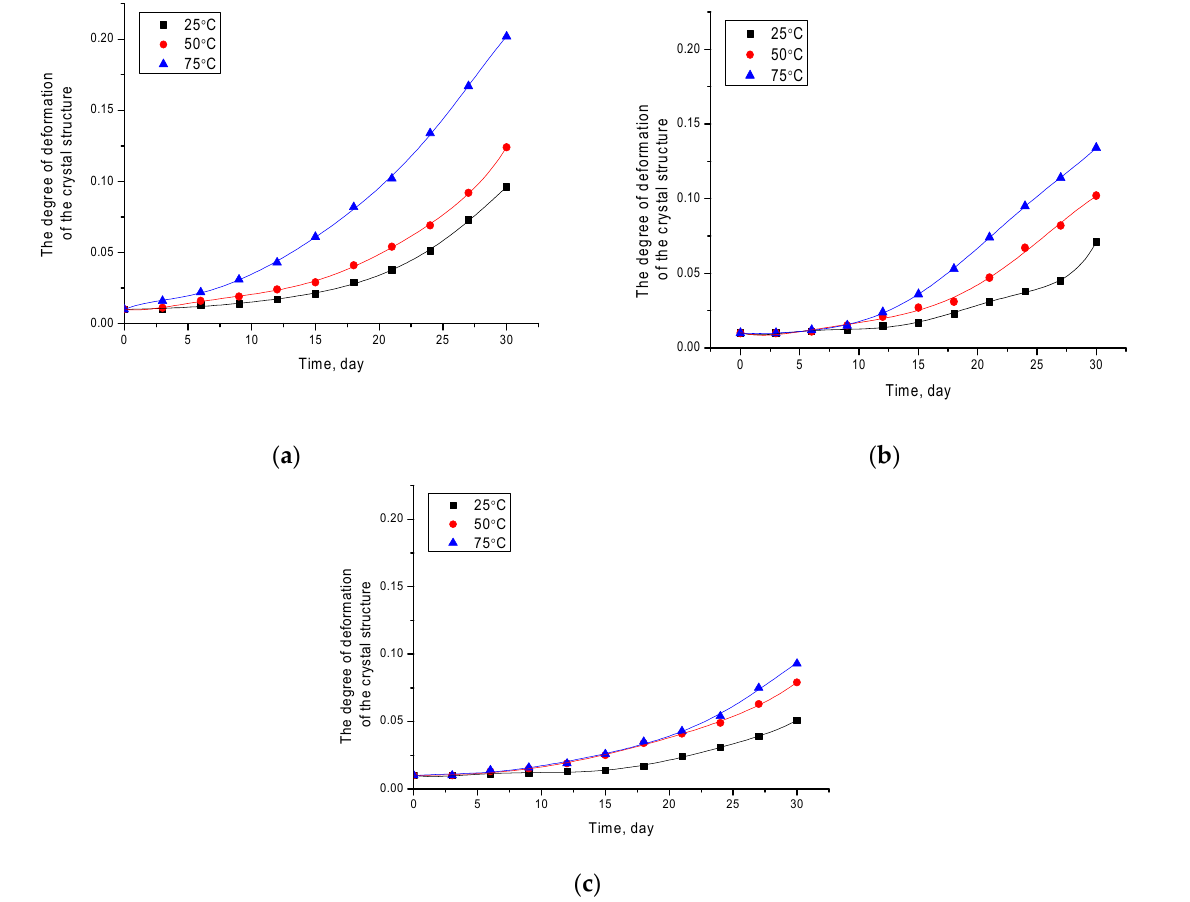
Figure 8. Graph of the change in the deformation degree of the crystal structure depending on the time spent in medium: ( a ) LTO-1; ( b ) LTO-2; ( c ) LTO-3.